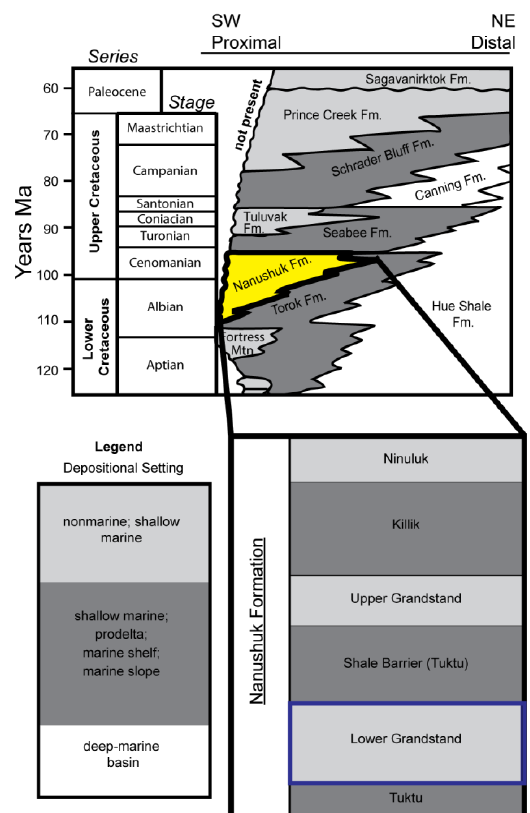
Figure 2. Stratigraphic column of the Nanushuk Formation, showing members and their depositional setting. Modified from Shimer et al., 2014